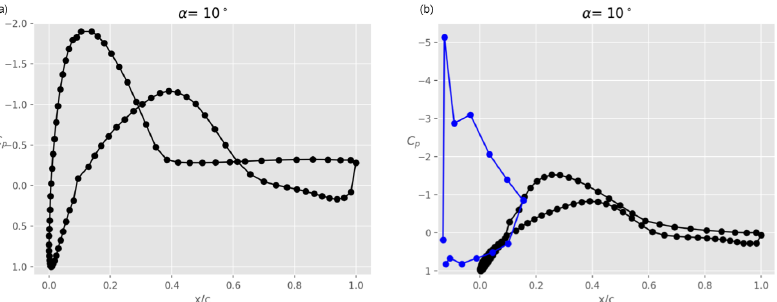
Figure 16. Pressure coefficient C p at α = 10 ◦ for a tripped main airfoil: main airfoil alone (a) and main airfoil with slat in case A (b) , where both the pressure distributions on the main airfoil (black) and slat (blue) are shown.